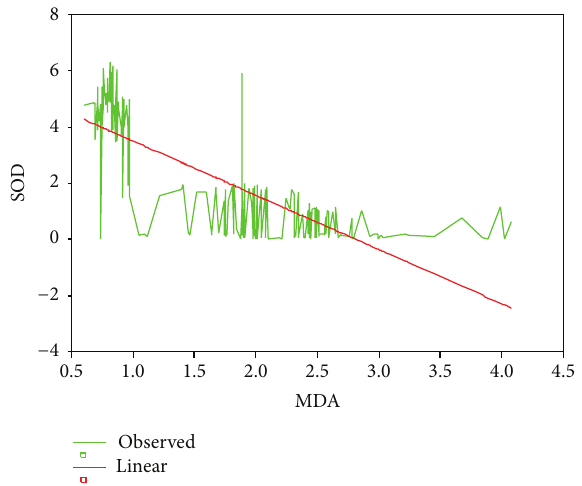
Figure 7: Correlation between SOD and Serum MDA in protein energy malnutrition ( 𝑃 < 0.001